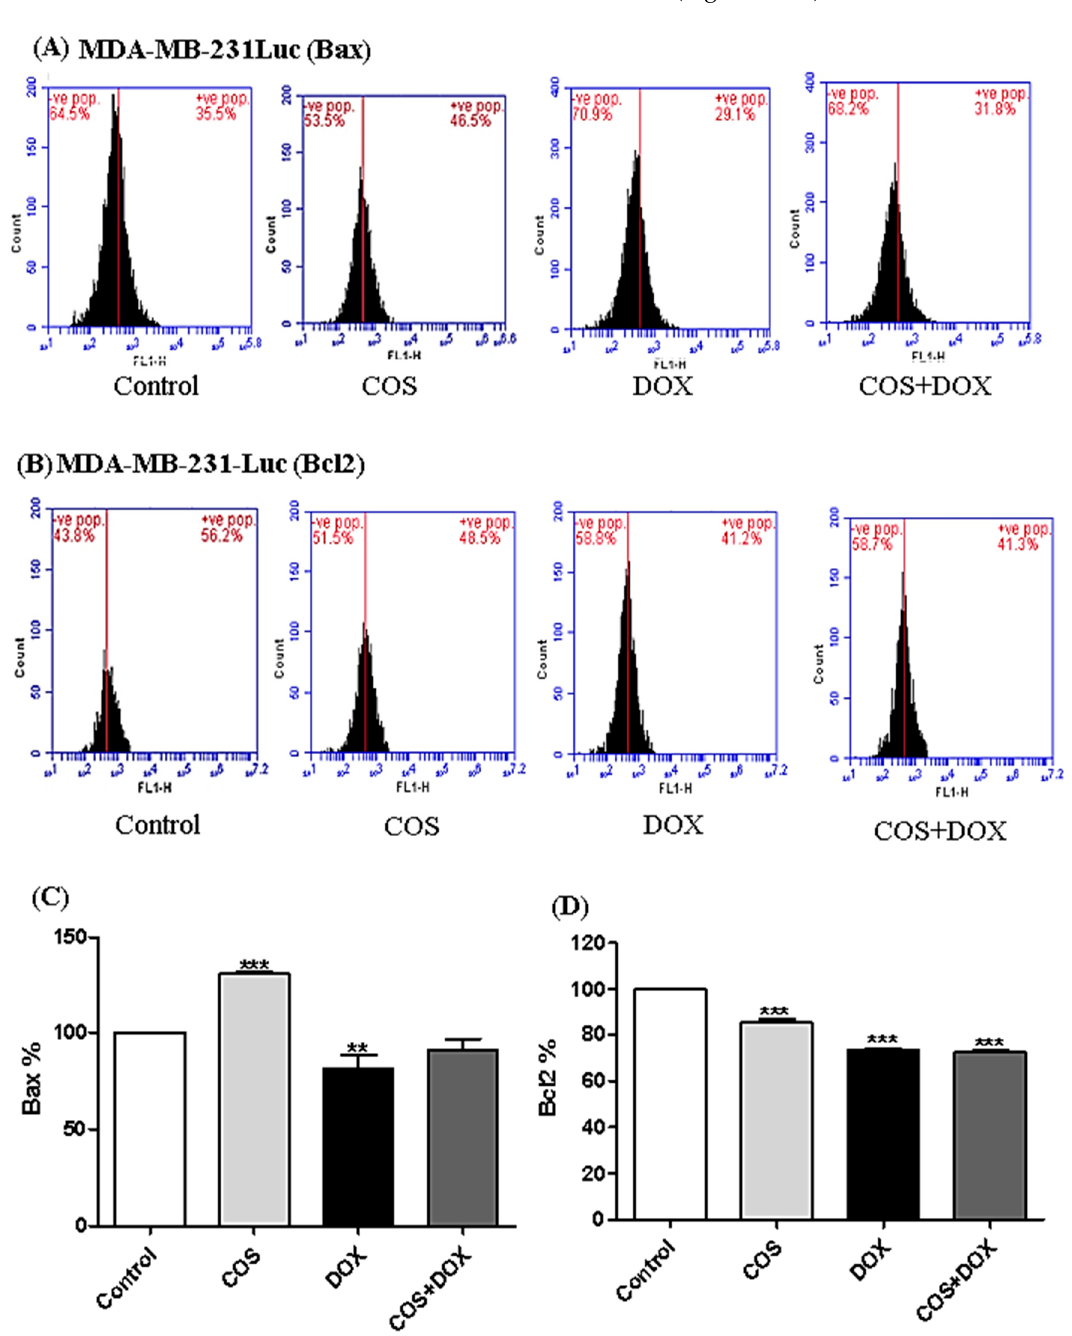
Figure 4. Bcl2-associated X protein (Bax) and B-cell lymphoma 2 (Bcl2) protein expressions in MDA-MB-231-Luc. ( A ) Bax flow cytometer histogram. ( B ) Bcl2 flow cytometer histogram. ( C ) Bax percentages in costunolide (COS), doxorubicin (DOX), and costunolide + doxorubicin (COS+DOX) relative to the control group. ( D ) Bcl2 percentages in COS, DOX, and COS+DOX relative to the control group. Values are presented as mean ± SD. ** p < 0.01 and *** p < 0.001.